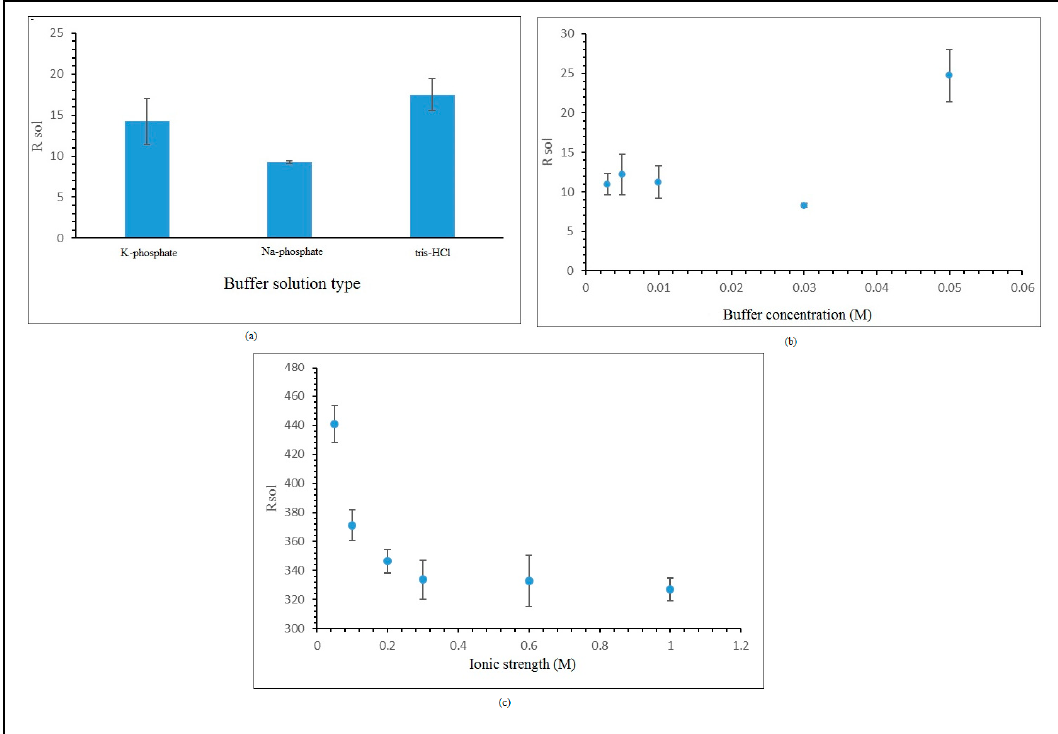
Figure 5. ( a ) E ff ect of measurement bu ff er solution type. ( b ) E ff ect of measurement bu ff er solution Figure 5. ( a ) Effect of measurement buffer solution type. ( b ) Effect of measurement buffer solution concentration. ( c ) E ff ect of salt concentration on measurement bu ff er concentration. ( c ) Effect of salt concentration on measurement buffer solution.